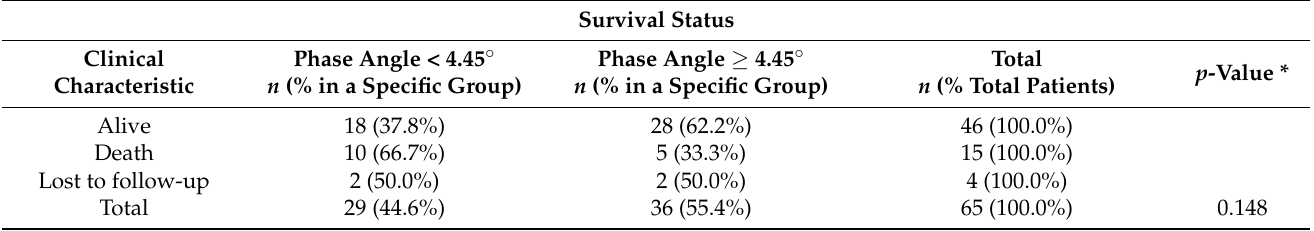
Table 4. Survival, death, and loss of